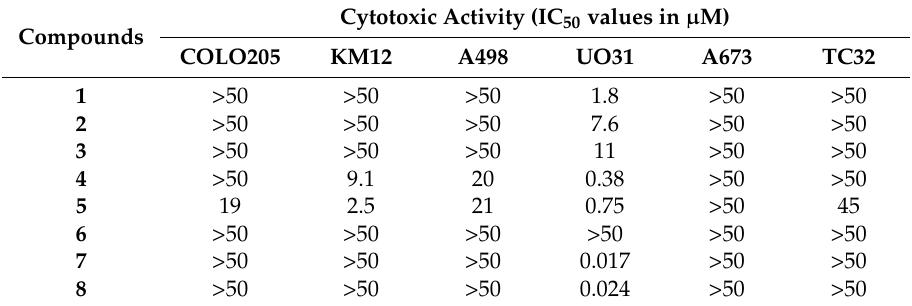
Table 3. Cytotoxic activities of sesquiterpene coumarin ethers isolated from Heptaptera anatolica. Cytotoxic Activity (IC 50 values in µ Compounds